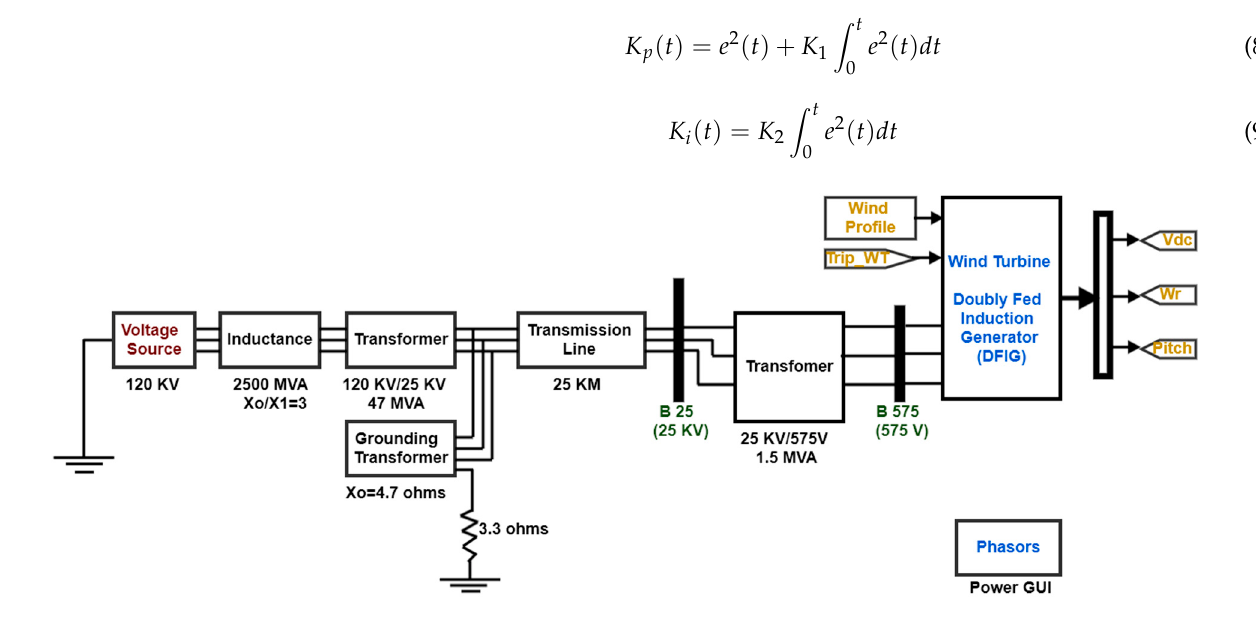
Figure 9. MATLAB model of wind-turbine DFIG.